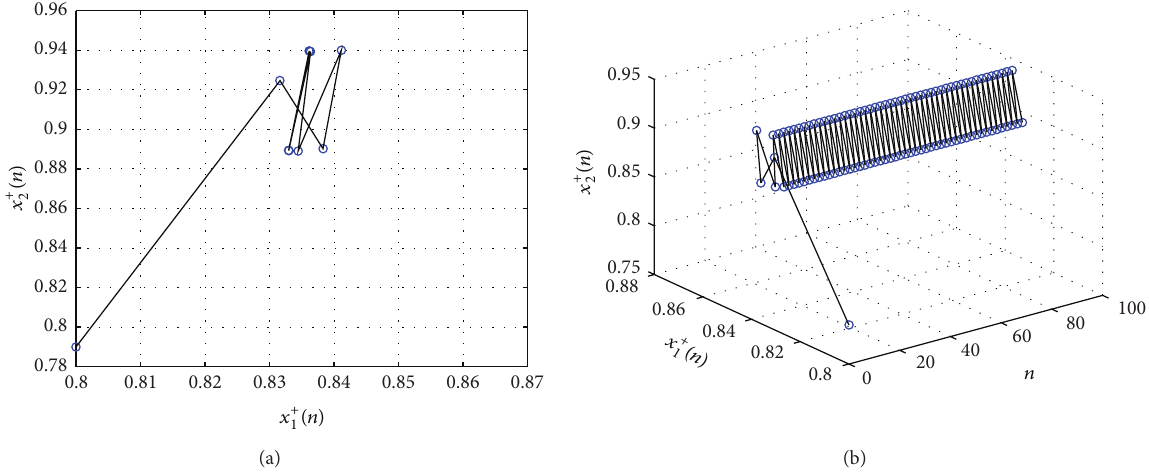
Figure 5: Phase portrait. (a) Two-dimensional phase portrait of 𝑥 + 1 (𝑛) and 𝑥 + 2 (𝑛) with initial values 𝑥 + 1 (−1) = 0.79 and 𝑥 + 1 (0) = 0.80 and (−2) = 0.85 , 𝑥 + (−1) = 0.80 , and 𝑥 + (0) = 0.79 for 𝑛 ∈ [0, 100] . (b) Three-dimensional phase portrait of 𝑛, 𝑥 + 𝑥 + 2 2 2 initial values for 𝑛 ∈ [0,100]